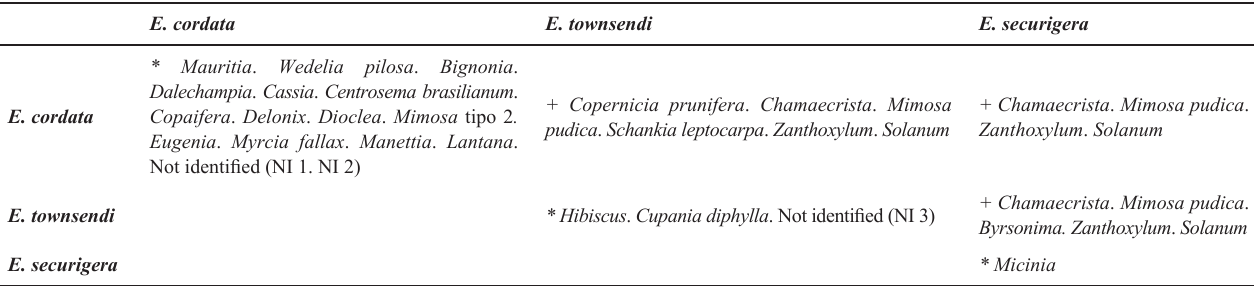
Table 3 . Exclusive pollen types (*) shared (+) by Euglossa cordata, E. townsendi and E. securigera nesting in trap nests in the Sítio do Rangedor State Park, Maranhão,